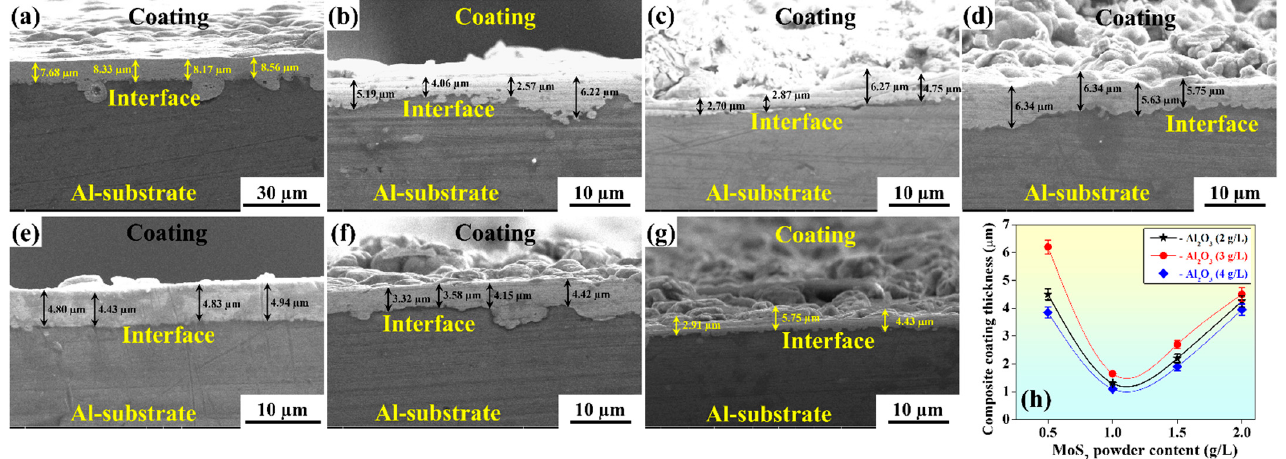
Figure 3. Composite coating thickness for ( a ) Ni-P coating without powder and 2 g/L Al 2 O 3 with ( b ) 0.5 g/L MoS 2 or ( c ) 2 g/L MoS 2 powder content; 3 g/L Al 2 O 3 with ( d ) 0.5 g/L MoS 2 or ( e ) 2 g/L MoS 2 ; 4 g/L Al 2 O 3 with ( f ) 0.5 g/L MoS 2 or ( g ) 2 g/L MoS 2 ; and ( h ) variation of coating thickness with different powder concentrations. Table 4. Thickness, microhardness, and surface roughness of each electroless coating. Experiment